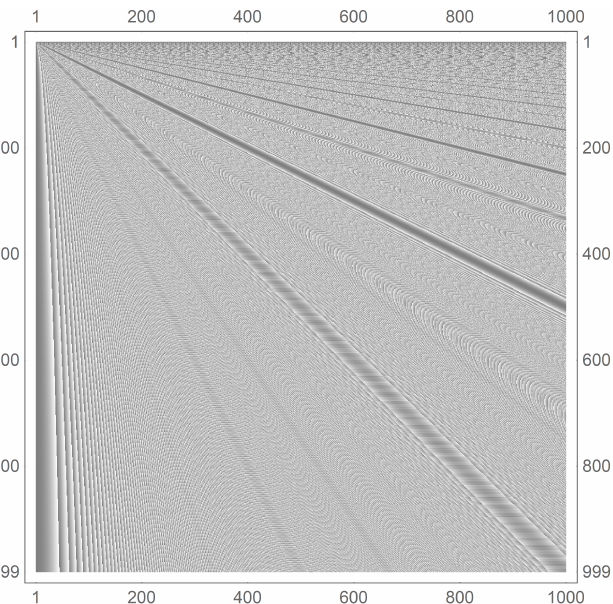
Figure 14. Visual representation of the structure of the triangular numbers modulo m for 0 ≤ m < 1000. The vertical axis is the m value and the horizontal axis is the value of T ( k ) mod m . The scaling structure is seen quite clearly as the eye sweeps from the lower-left corner to the upper-right corner of the plot. Gray represents low values and white represents high values (values normalized by 1/ m to show better